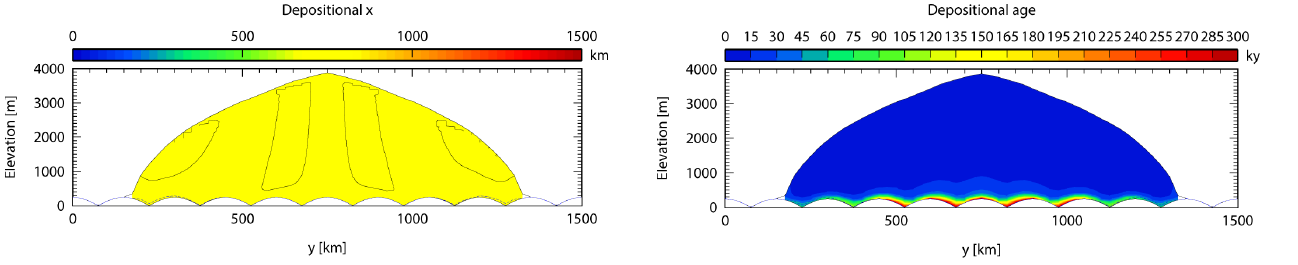
Figure 9. Age of the ice derived by calculating t final − t d where t final is the final time of the simulation. The older ice is located near the base and the majority of the ice is younger than 30kyr.